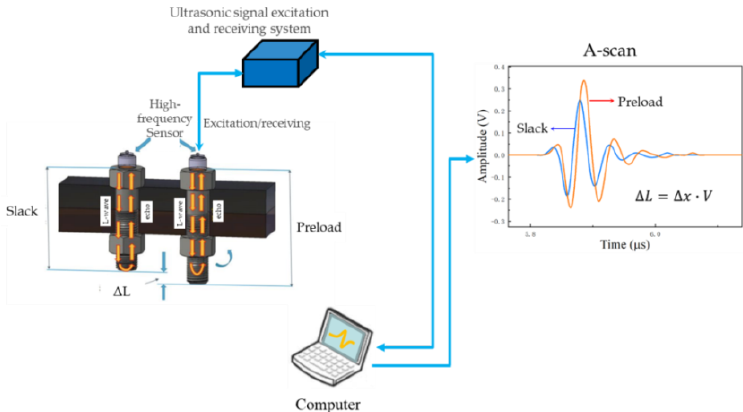
Figure 1. Experimental setup schematic and fundamental principle diagram of measuring bolt axial preload by the mono-wave method. (L-wave: longitudinal wave, V: velocity of longitudinal wave, ∆ L, ∆ x: length and time change of the smart bolt induced by the preload compared with the slack bolt). In this work, smart, nickel-based superalloy bolts with a high-frequency, piezoelectric thin-film sensor were successfully fabricated by radio frequency magnetron